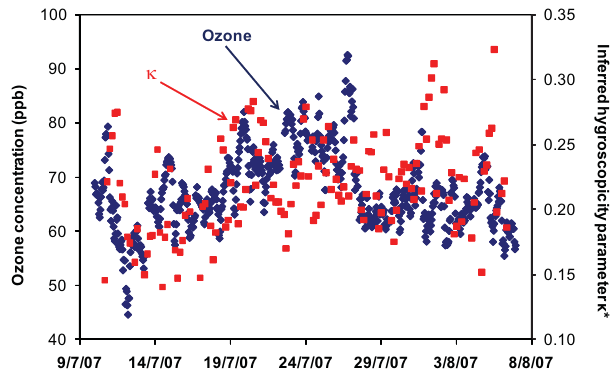
Fig. 10. Time series of κ ∗ versus ozone